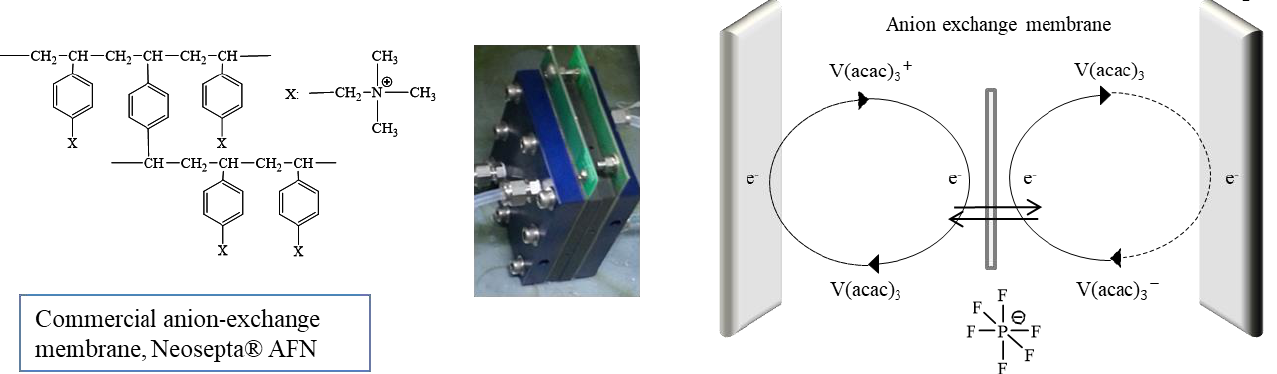
Figure 3. Chemical structure of the commercial anion-exchange membrane (Neosepta ® AFN) and images of the single cell for electrochemical capacitor performance.